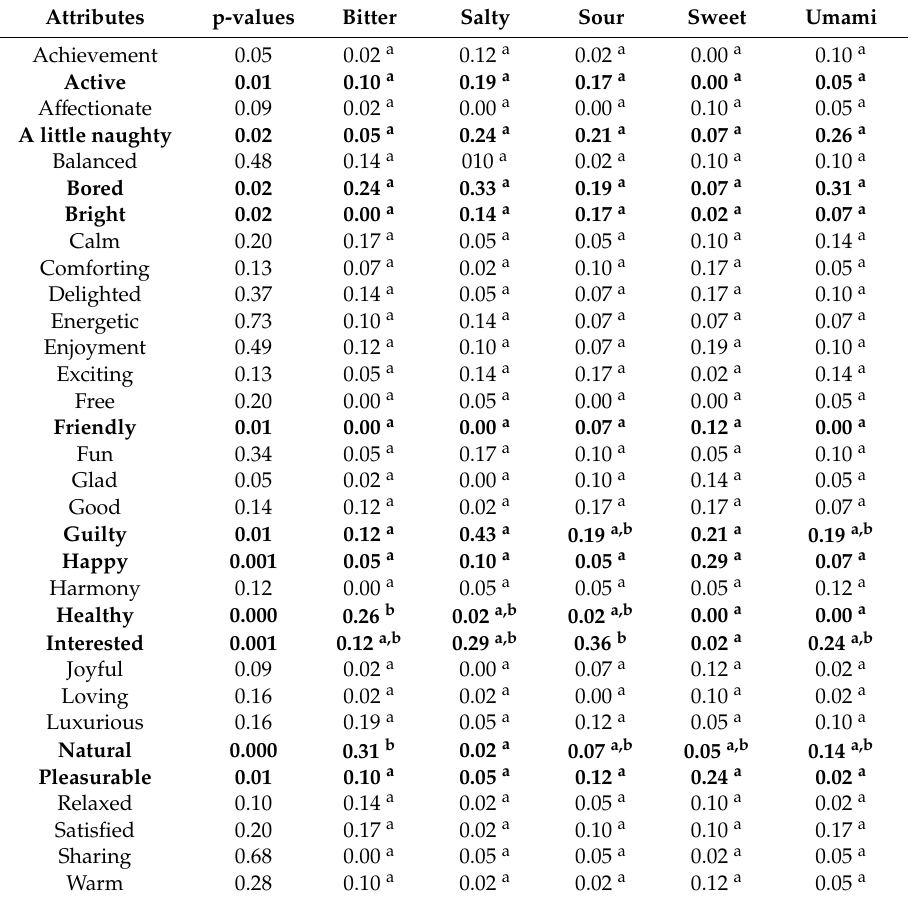
Table 6. Cochran’s Q test results for each emotion-based term of chocolate with basic tastes.